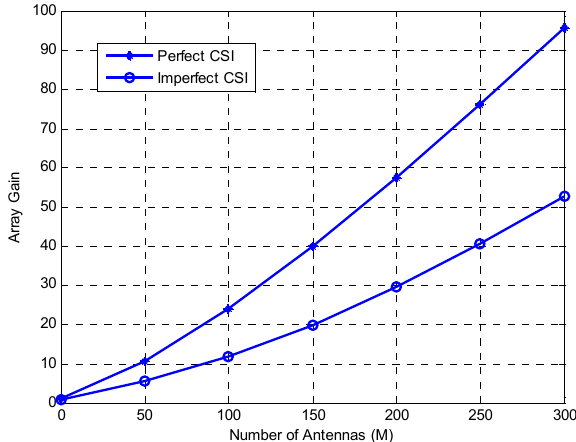
Figure 5. Array gain vs. number of antennas in multi-cell system with K = 15 users, L = 7 and transmit power = 10 dB.